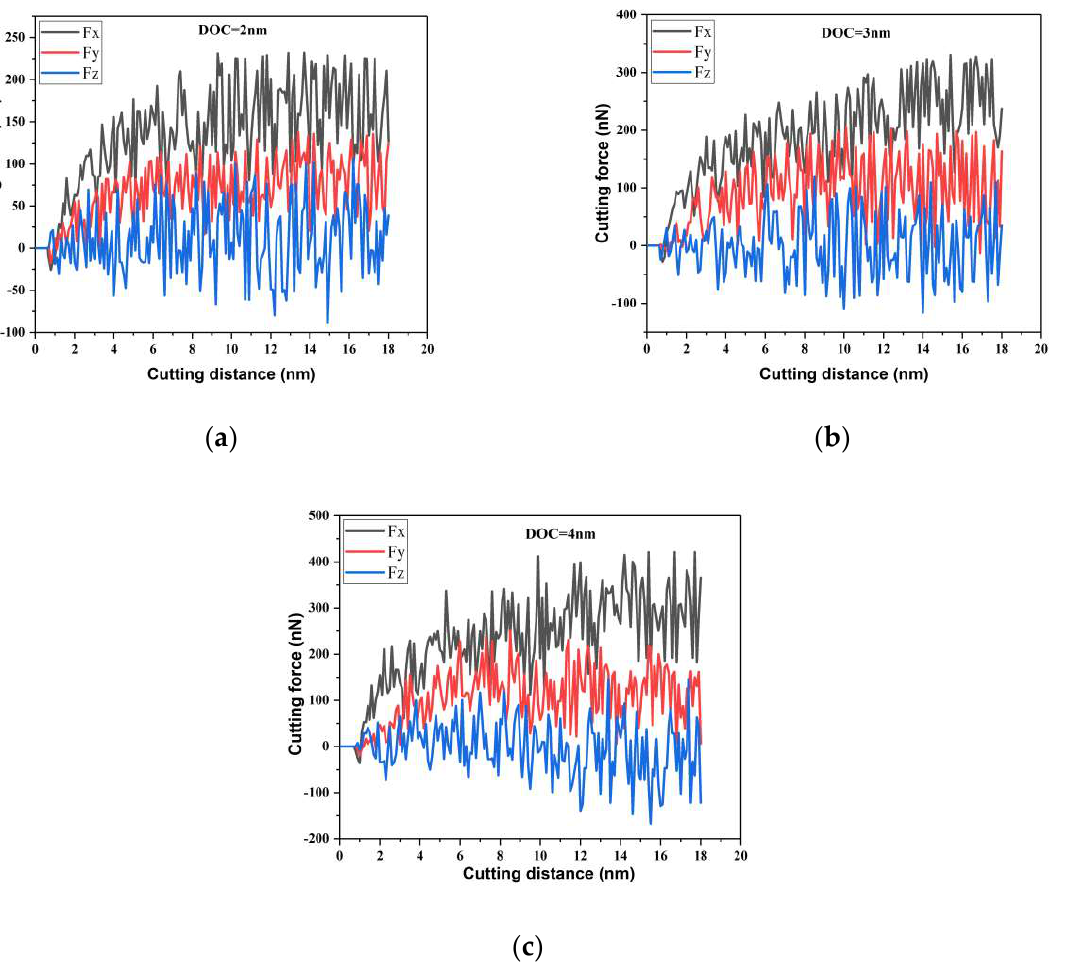
Figure 2. Cutting force at different cutting depths with water medium (( a ) cutting depth is 2 nm ( b ) cutting depth is 3 nm ( c ) cutting depth is 4 nm).